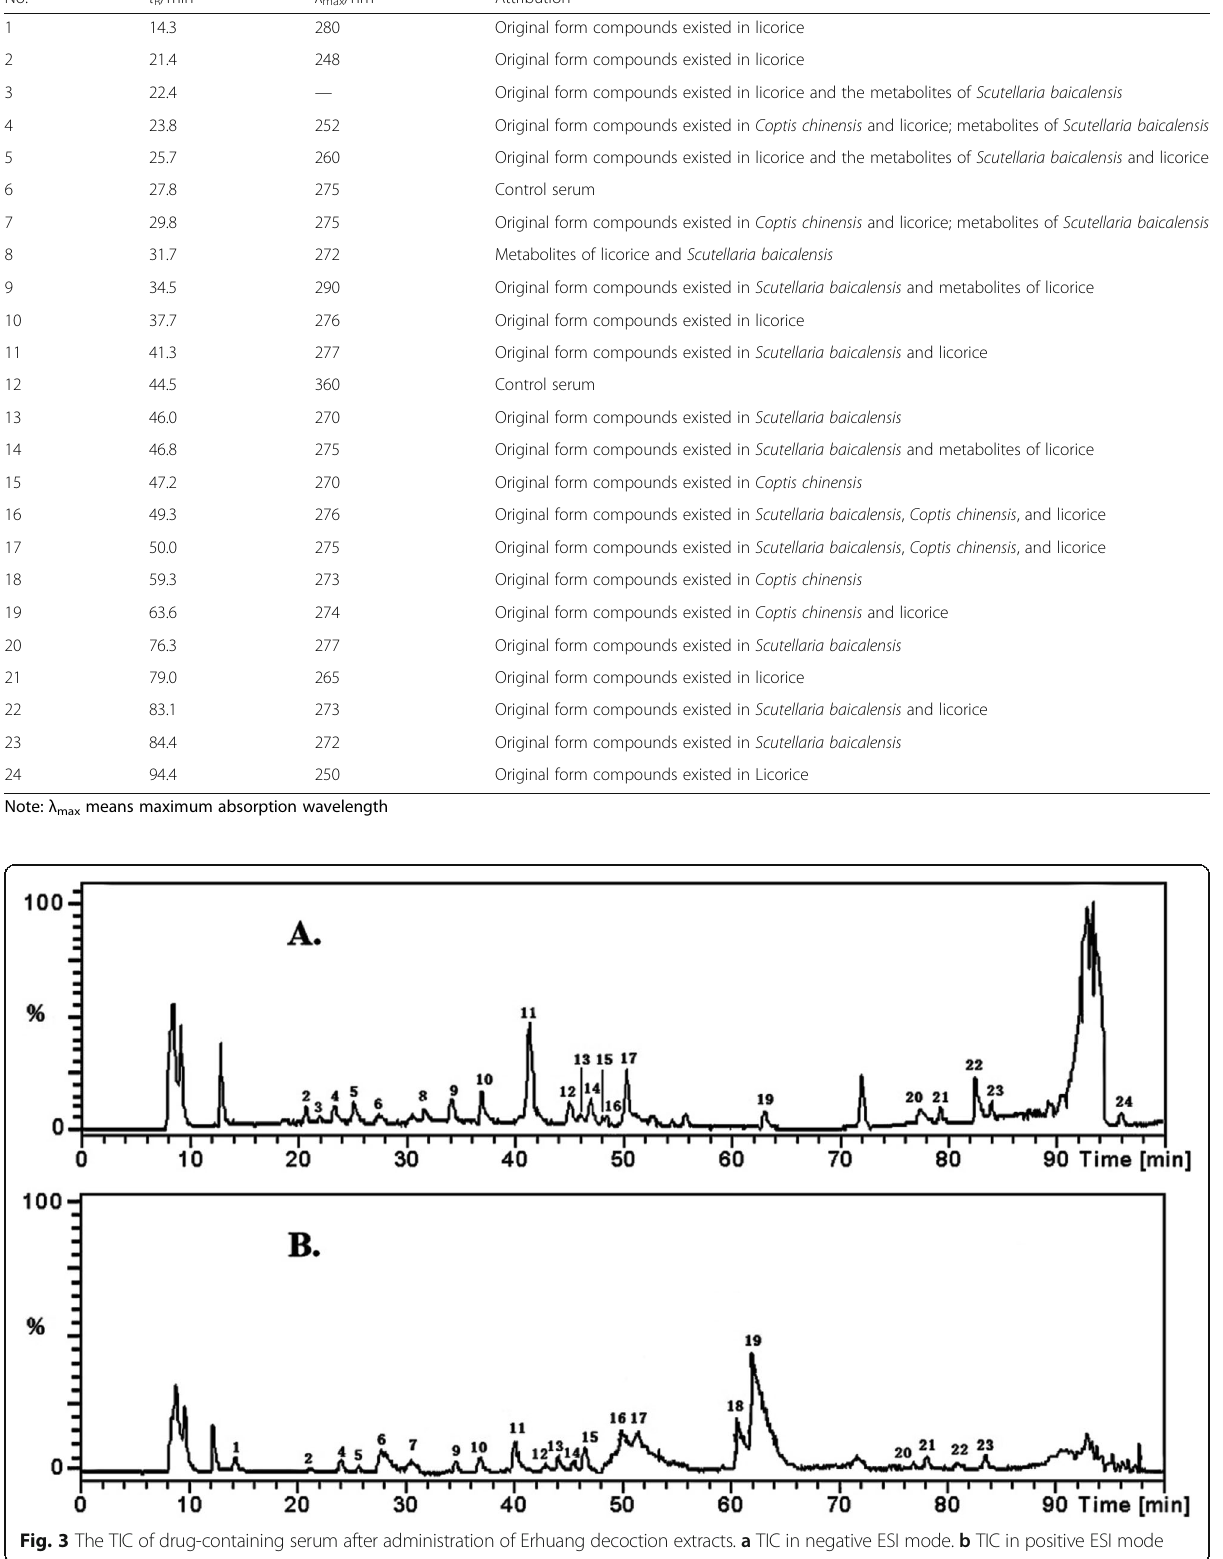
Table 1 Spectra data and the attribution results of 24 peaks of serum fingerprints after oral administration of Erhuang decoction No.